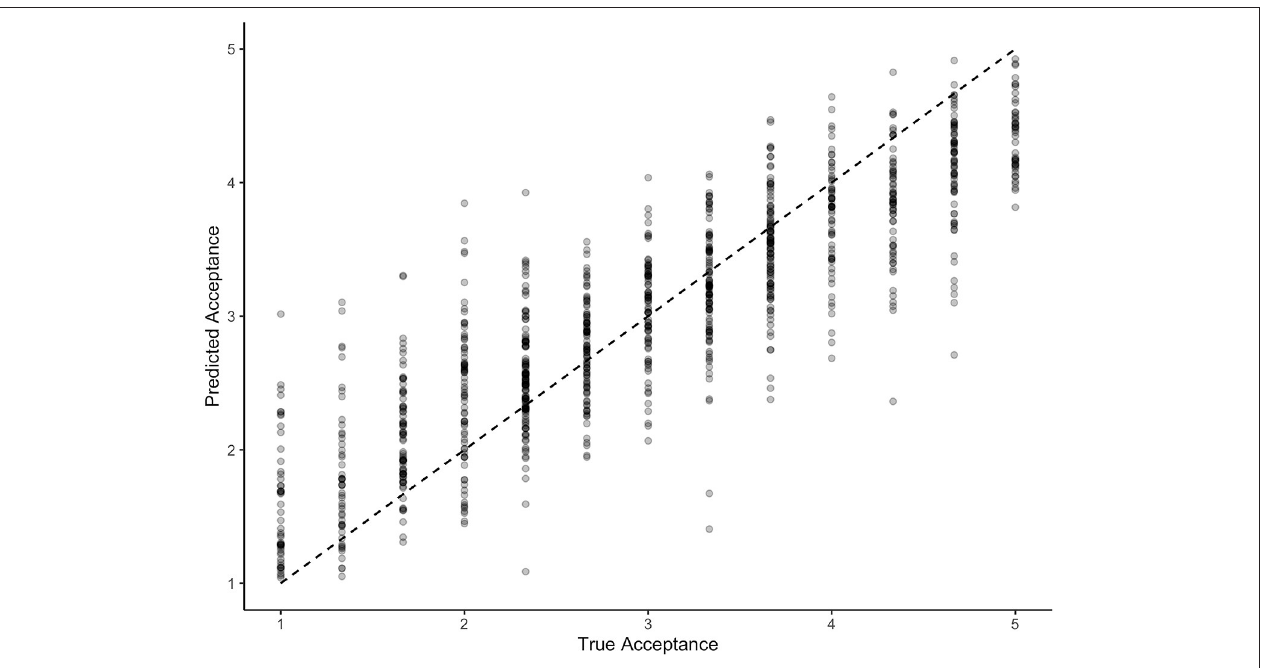
FIGURE 3 | Predictive Performance of the Advanced UTAUT